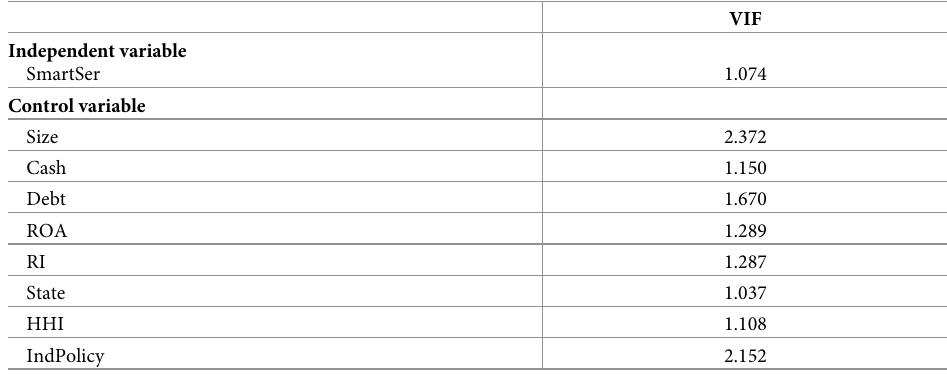
Table 5. Variance inflation